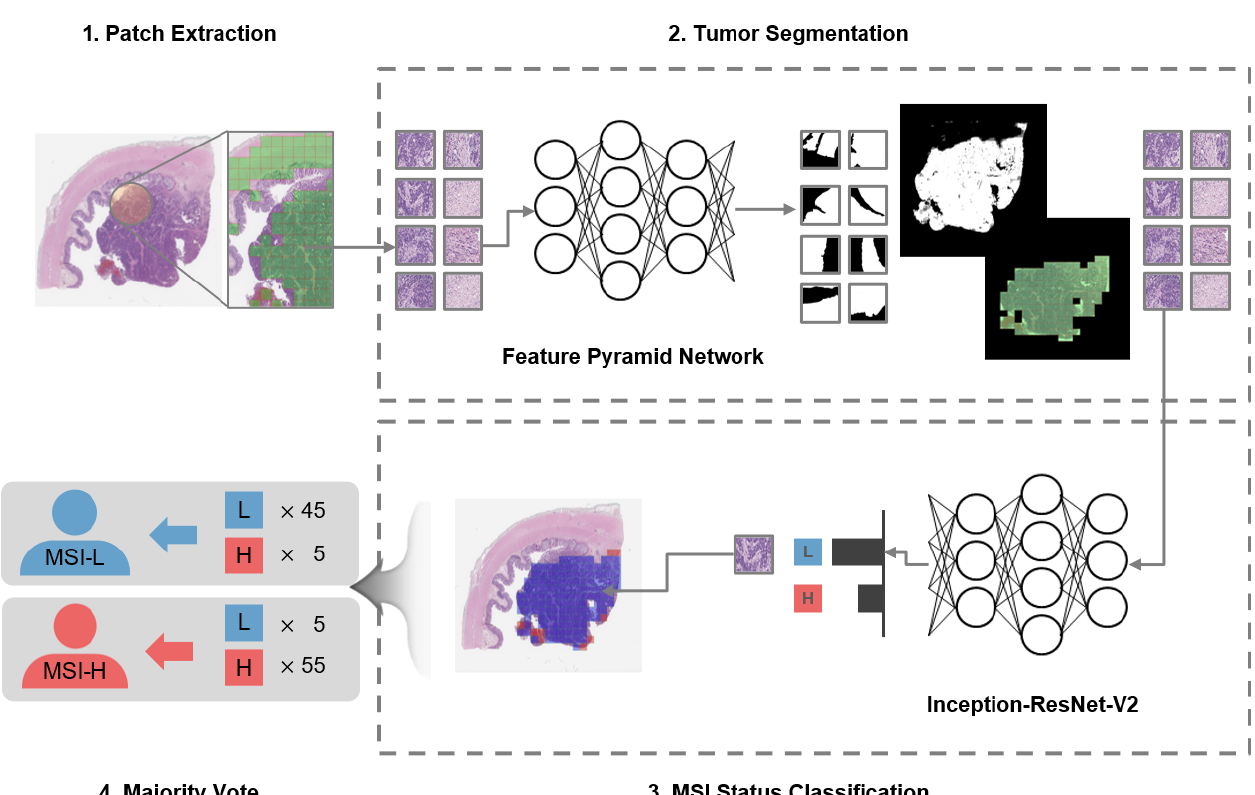
Figure 3. Two-stage classification pipeline for microsatellite instability (MSI) status